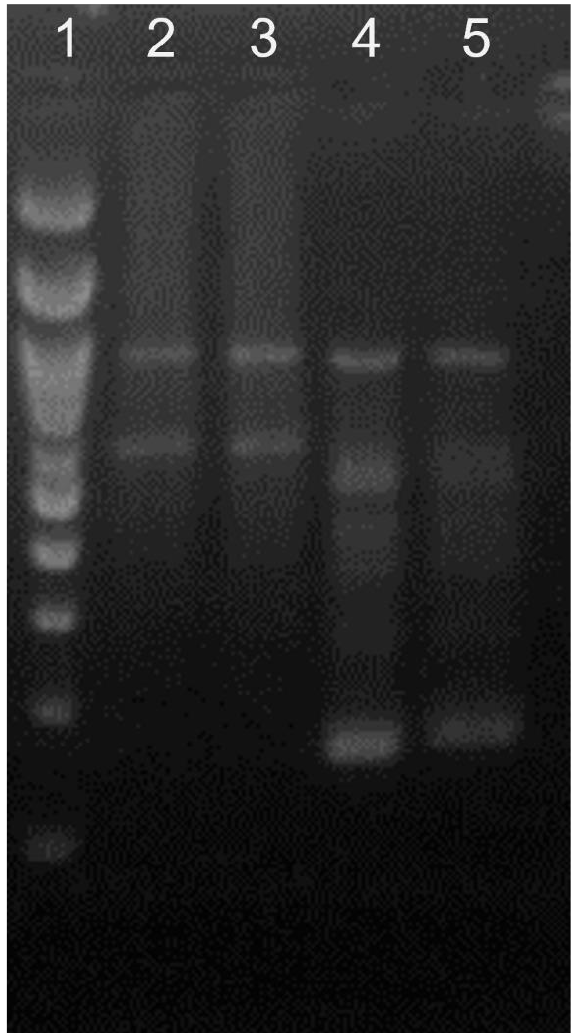
Figure 2. Gel image for the BoGHV6 PCR assays. Lane 1, 100 bp DNA ladder. Lanes 2 and 3, samples in duplicate PCR for BoGHV6 (551 bp); Lanes 4 and 5, samples in duplicate, Nested-PCR for BoGHV6 (166 bp).